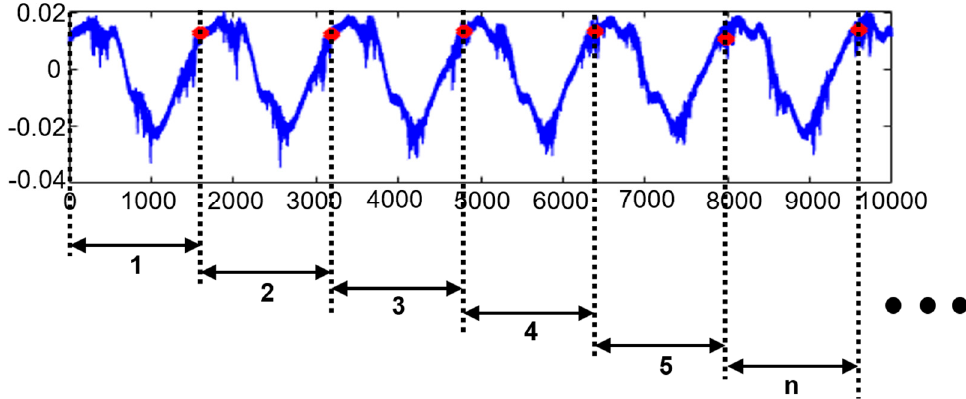
Figure 3. The vibration signal resampling process.